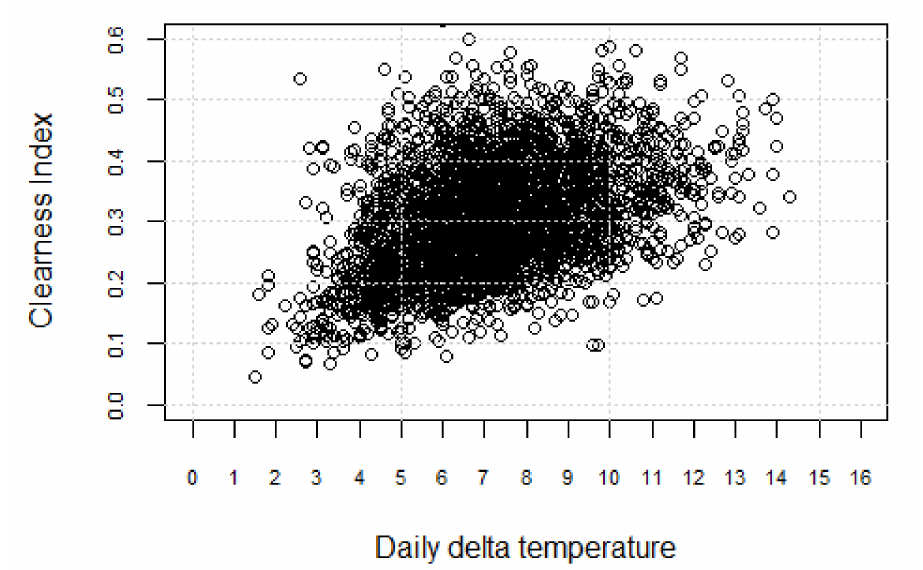
Figure 7. Daily delta of temperature–clearness index for